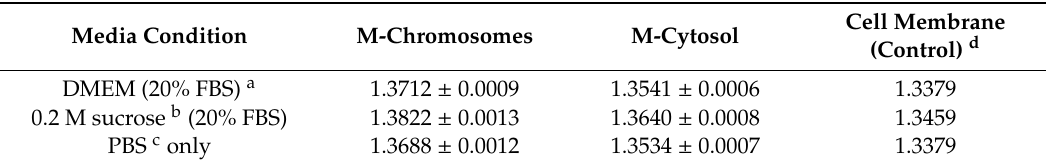
Table 2. Summary of refractive indices of mitotic chromosomes and cytosol in live DM cells cultured at 37 ◦